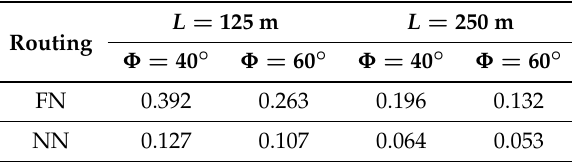
Figure 6. η versus β with λ = 0.015, Φ = { 40 ◦ ,60 ◦ } , and R = { 50 m, 33.3 m } . Table 3. Blockage-free normalized transmit energy consumption Υ .